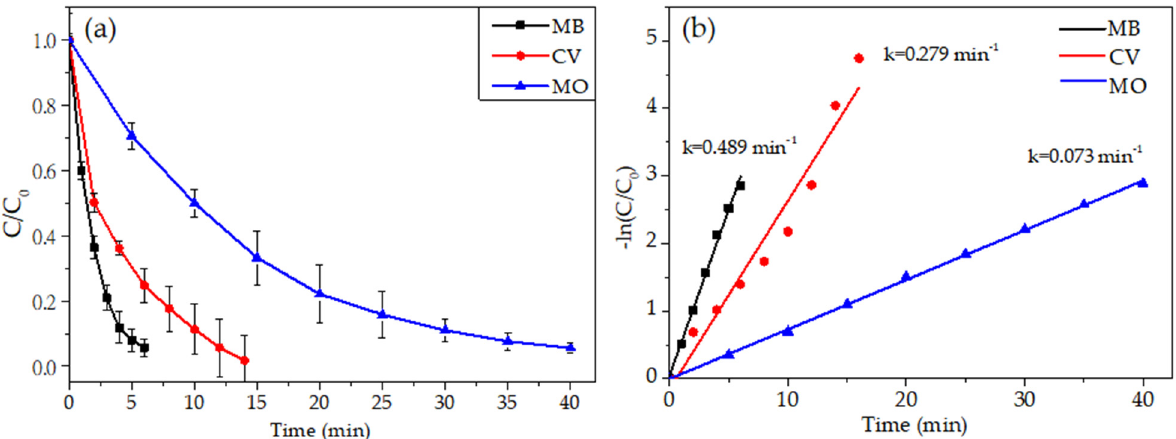
Figure 8. ( a ) Photocatalytic results of Ag 3 PO 4 /TiO 2 @Ti 3 C 2 (sample A4) and ( b ) the corresponding rate constants for organic dyes.